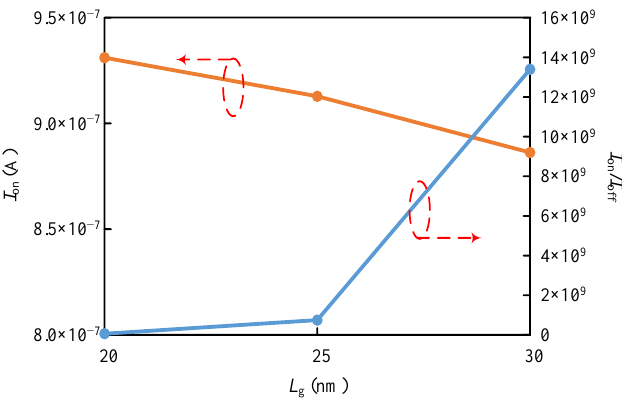
Figure 16. The I on and I on / I off of the MAJ logic device with same body thickness and oxide thickness.